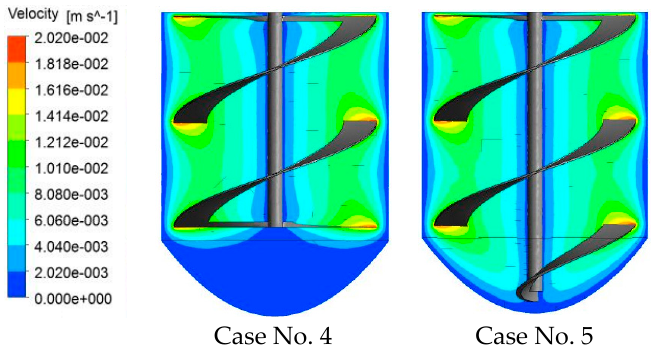
Figure 6. Velocity contours for Re = 10. Table 4. Power number for Re = 10.